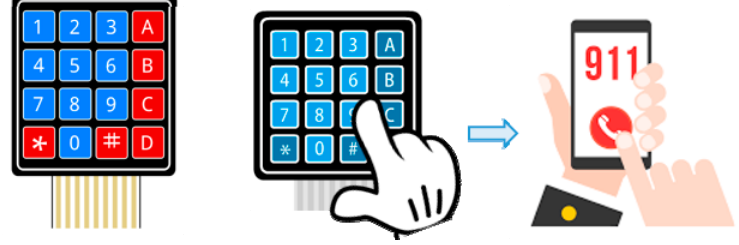
Figure 4. The thin-film keyboard.